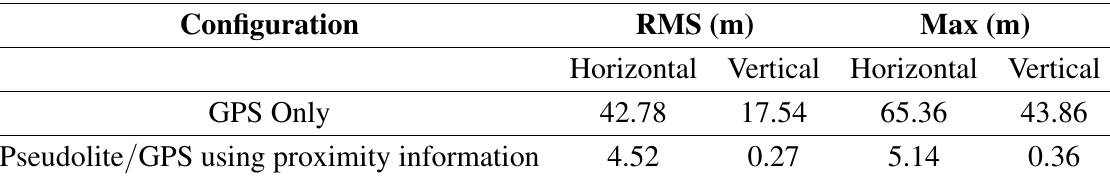
Table 1. Hybrid pseudolite / GPS statistical position error parameters: RMS and maximum errors for both horizontal and vertical components for the partially obstructed scenario.